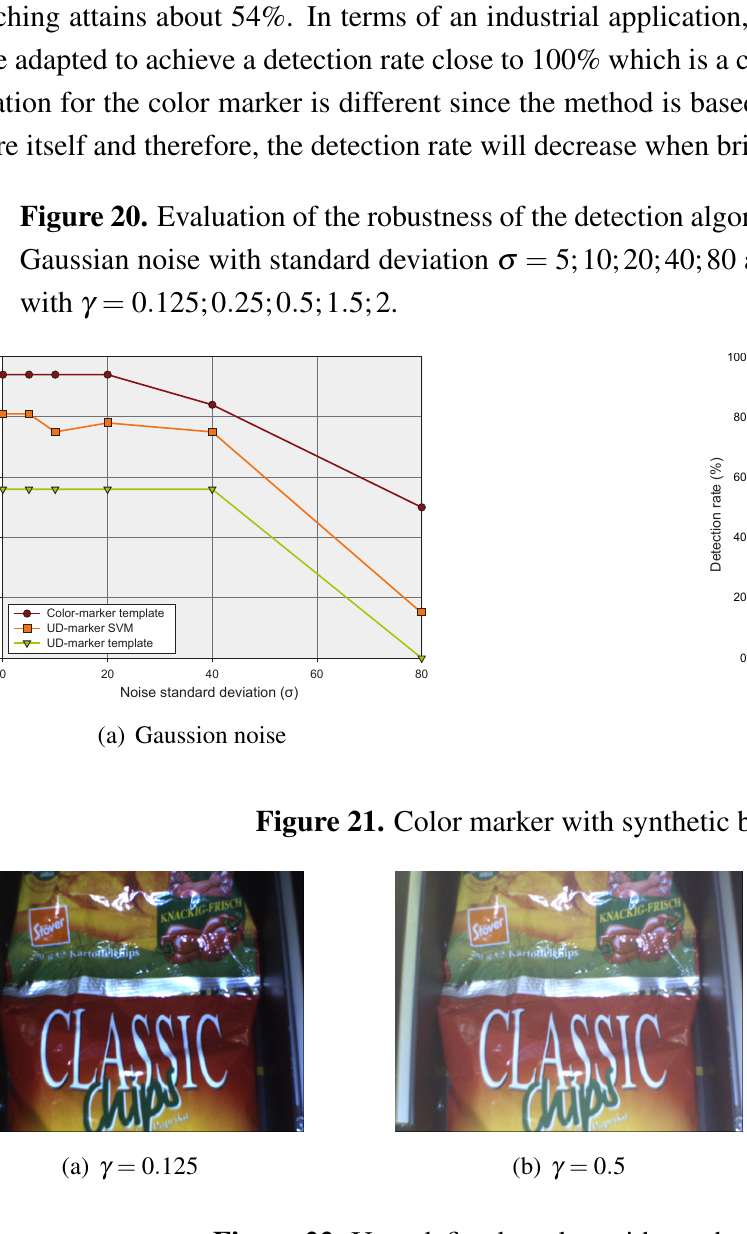
Figure 22. User-defined marker with synthetic